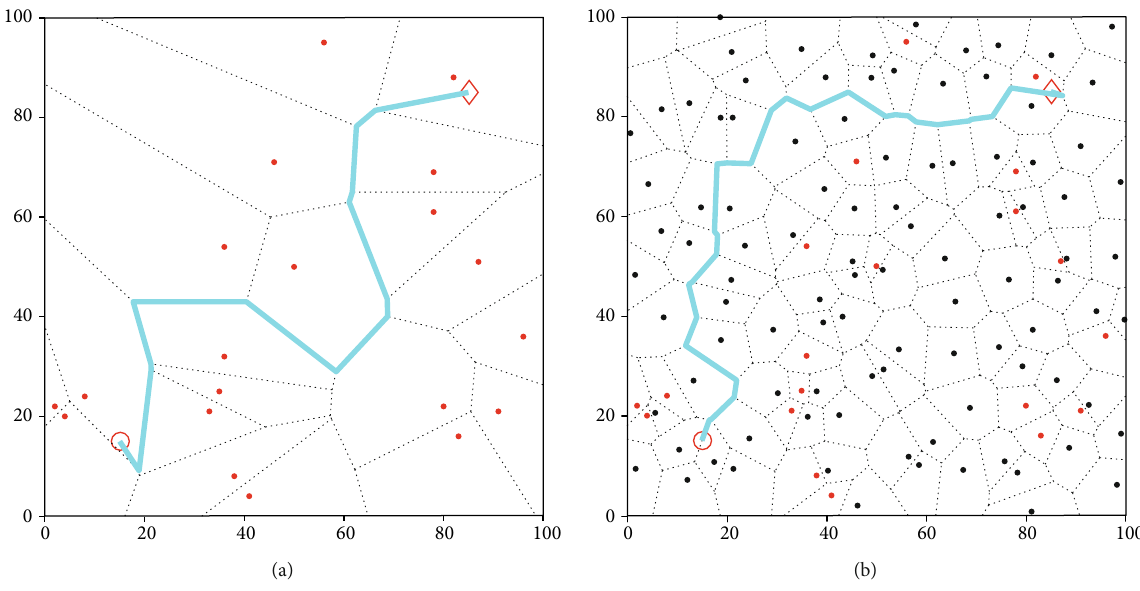
Figure 9: Initial paths generated from the Voronoi diagram and Dijkstra algorithm. (a) Voronoi edges from SAM sites. (b) Voronoi edges from virtual points in addition to SAM sites. A circle denotes a starting point, and a diamond denotes a destination.